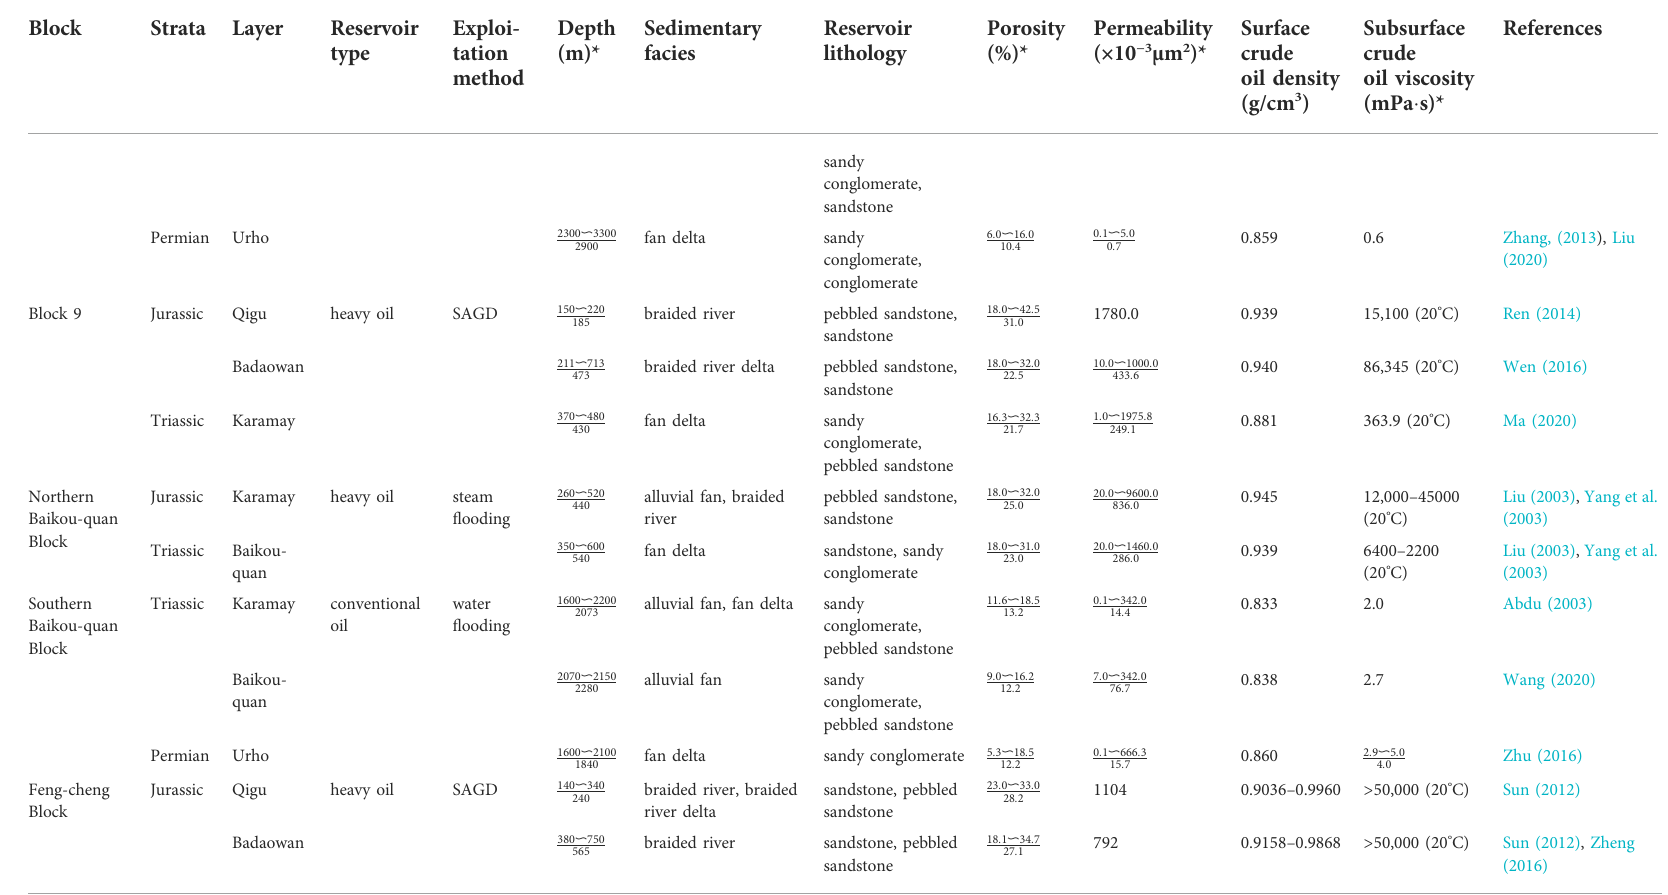
TABLE 2 ( Continued ) Geological data and oil fi eld data of different